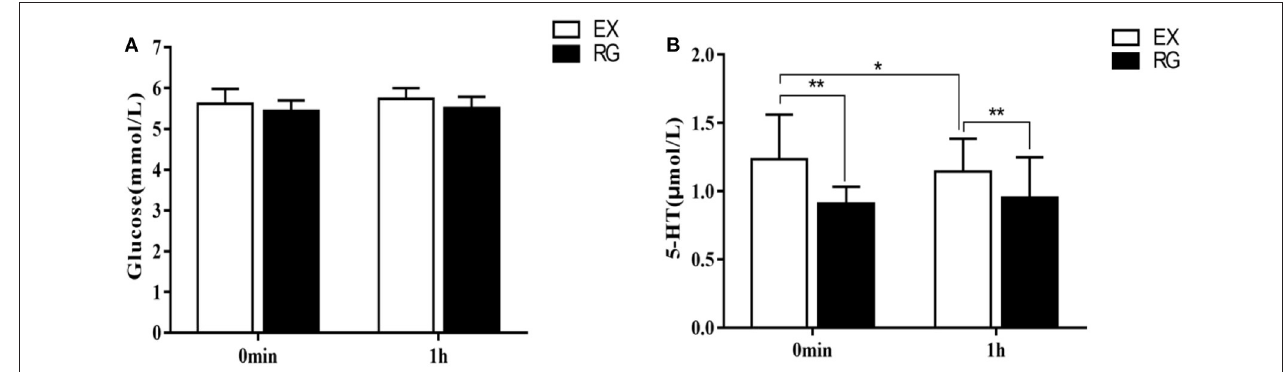
FIGURE 5 | Comparison of changes in fasting blood glucose and 5-ht content after exercise intervention. (A) Change in the content of glucose and (B) Change in the content of 5-HT. * p < 0.05, ** p < 0.01.